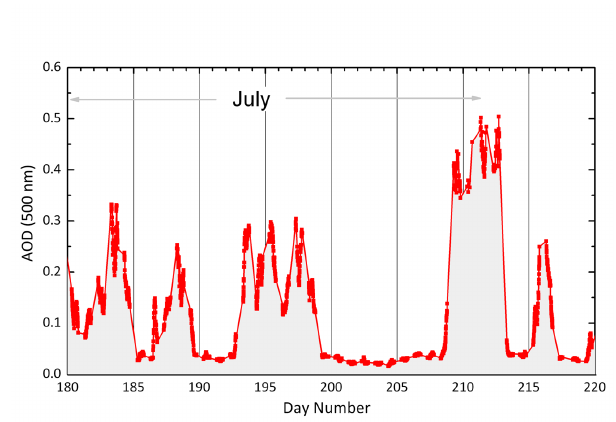
Figure 8. Integrated AOD at 500nm obtained at the Izaña station on days 180–220 of